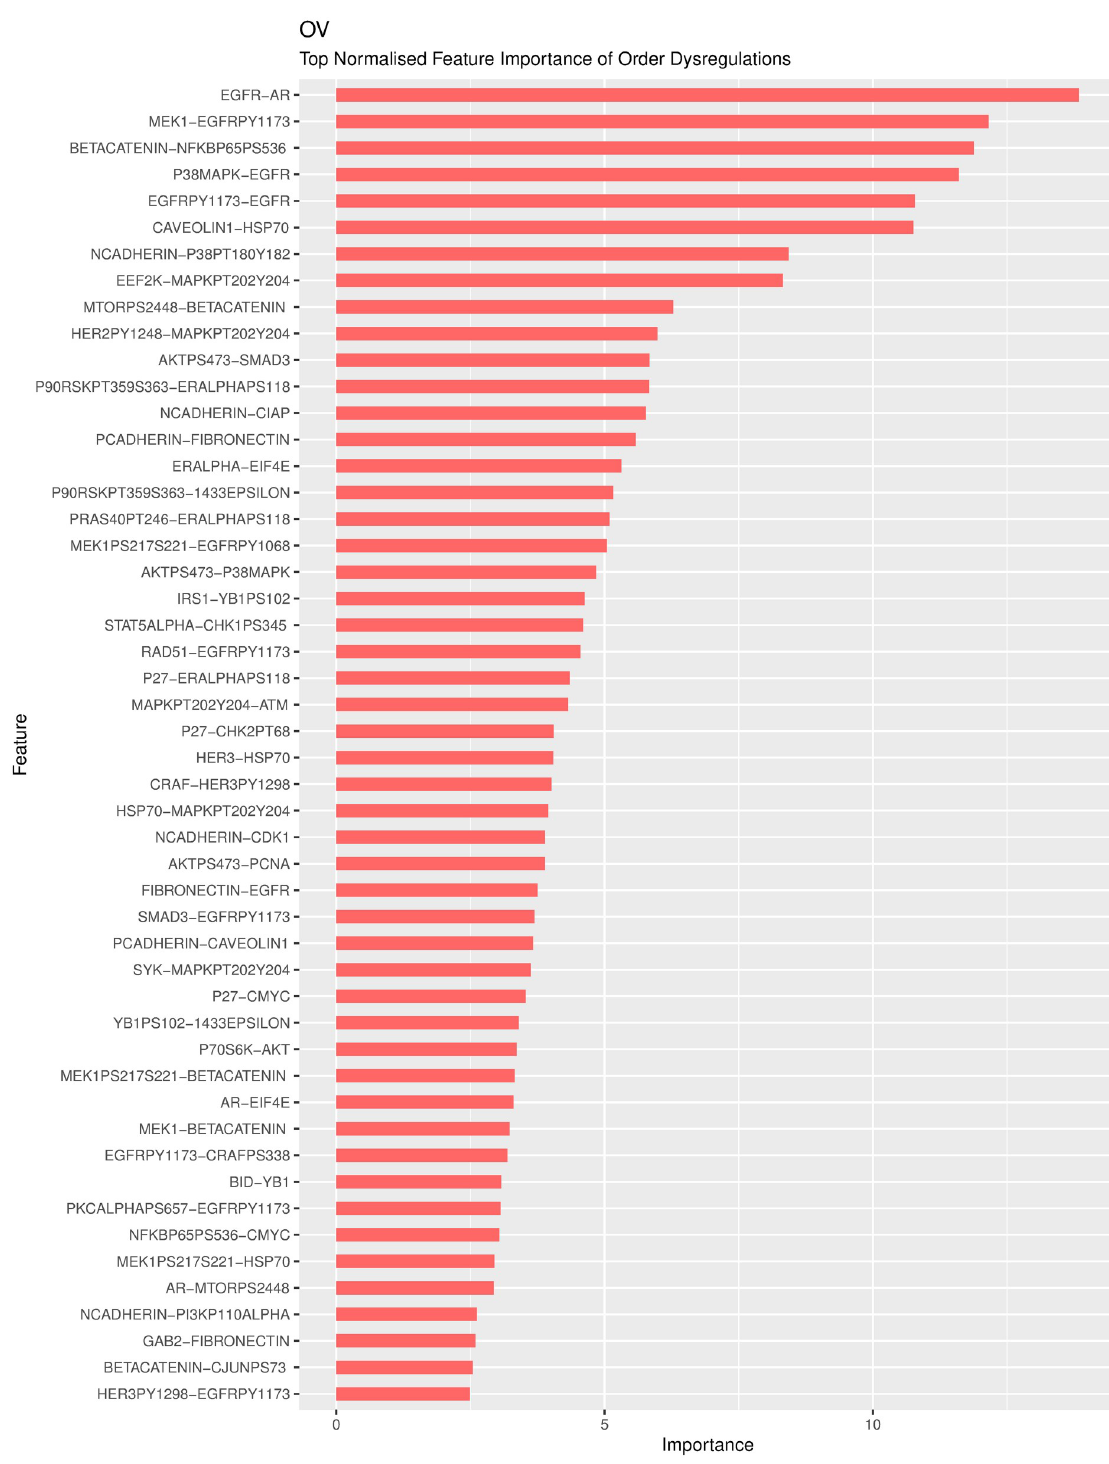
Fig 4. The variable importance of significant pairwise ranking representations for ovarian cancer.